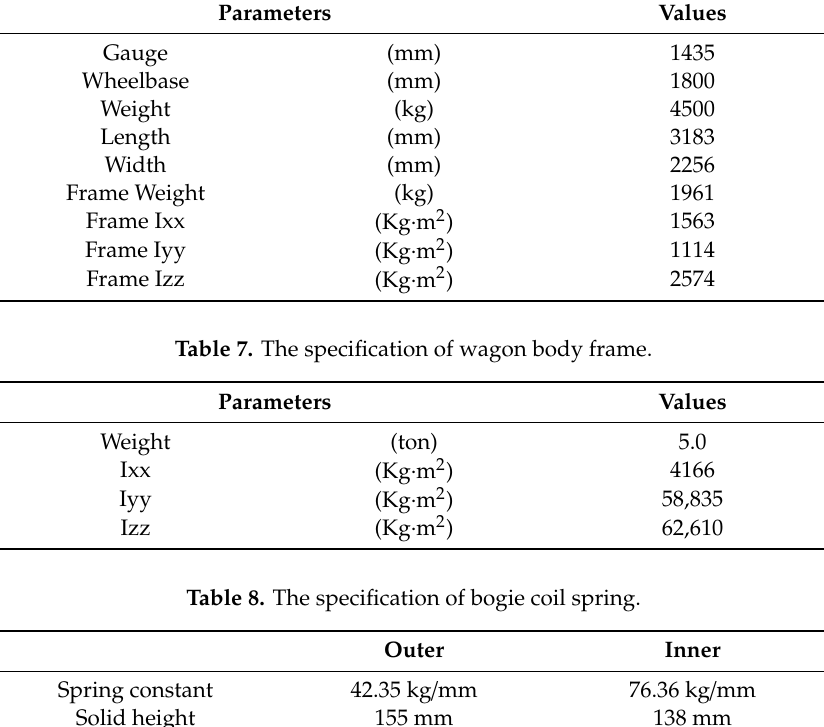
Table 8. The specification of bogie coil spring.